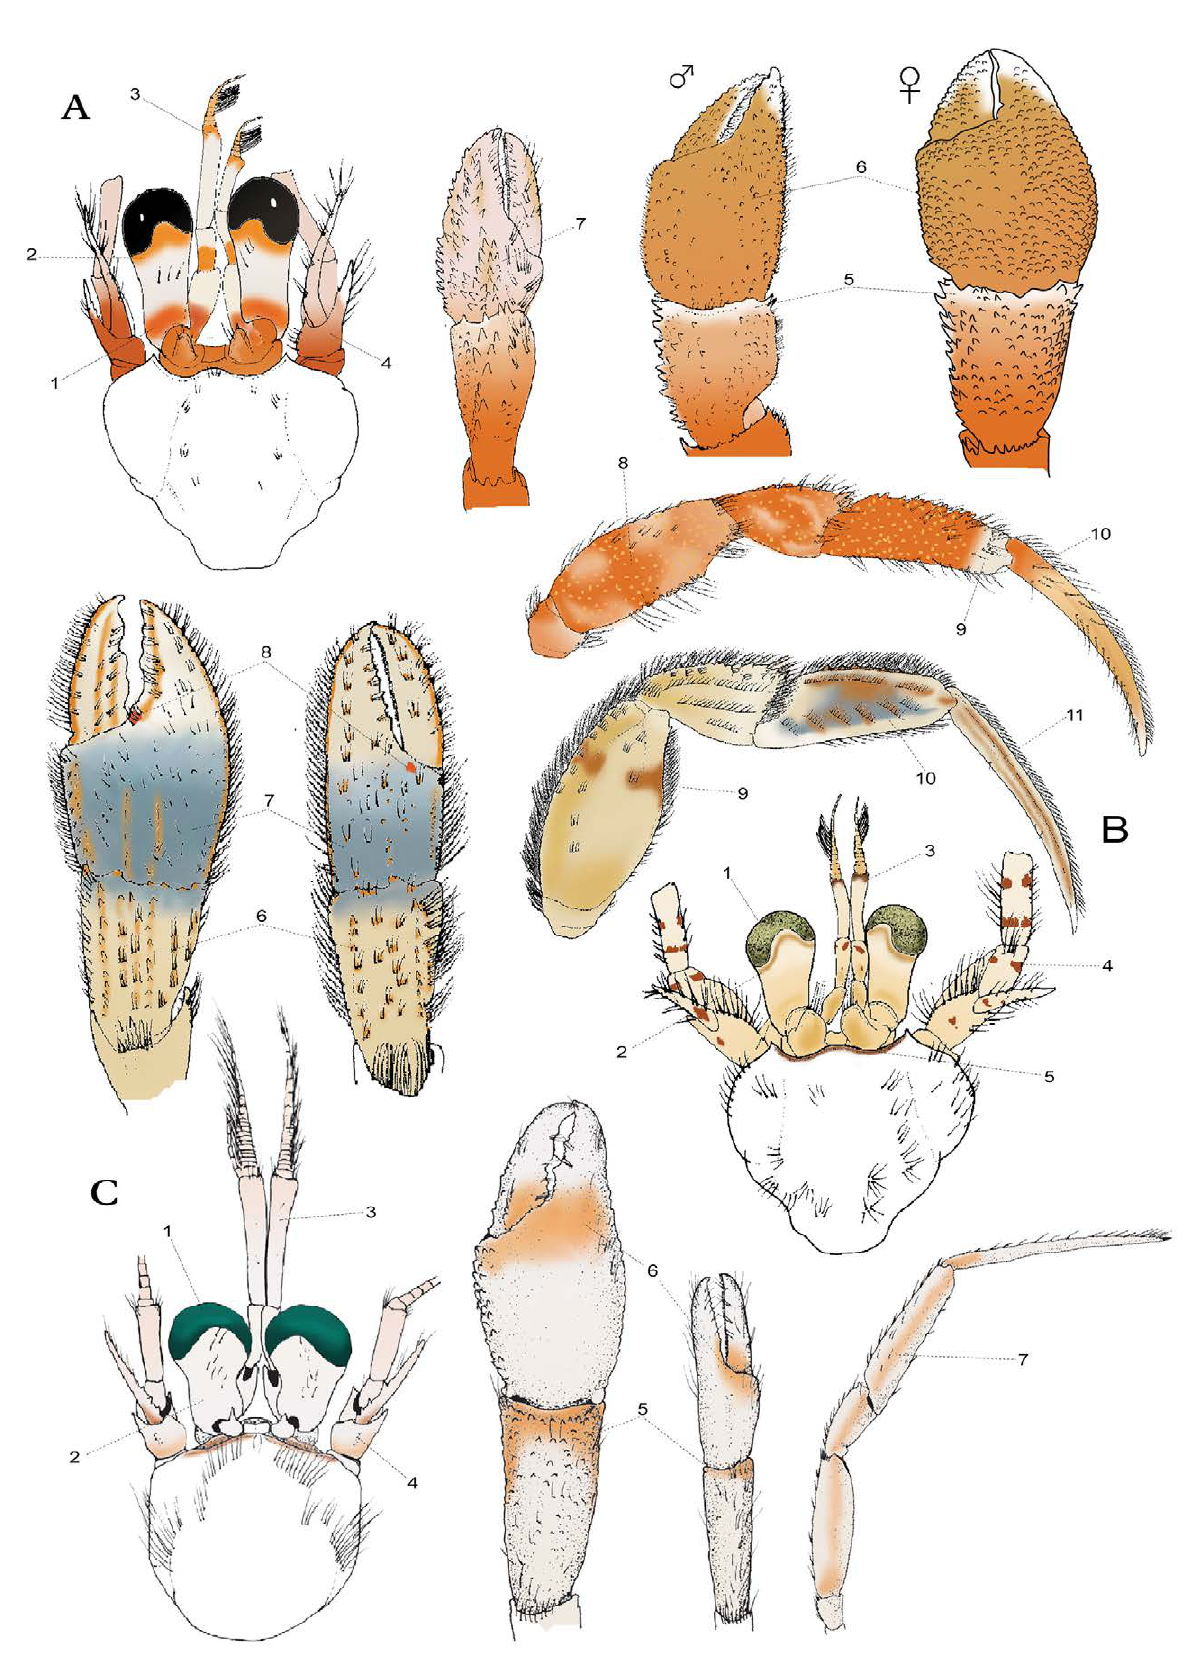
Fig. 12. – Colour patterns of Paguridae and Parapaguridae species: Pagurus pubescentulus (A, 1-10); Spiropagurus elegans (B, 1-11); Strobopagurus gracilipes (C, 1-7). Vectorial drawings modified from A-B, Ingle (1993); C, Lemaitre